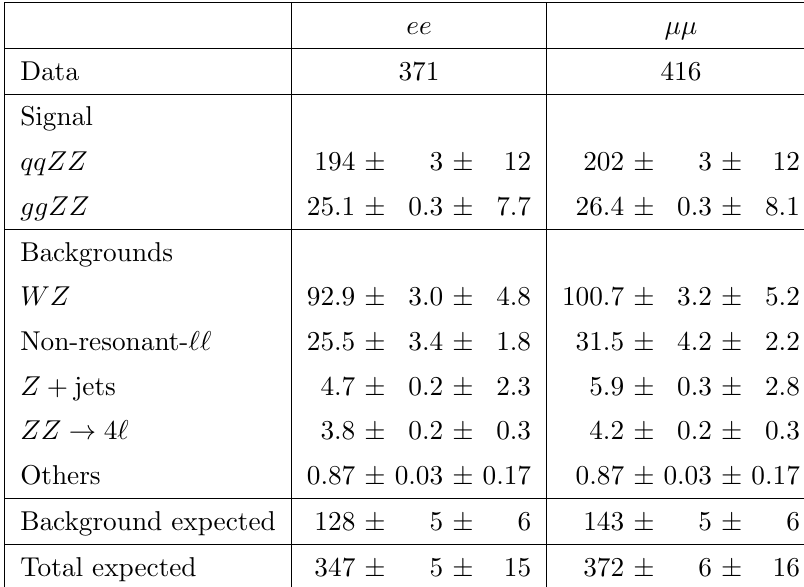
fraction for the ZZ